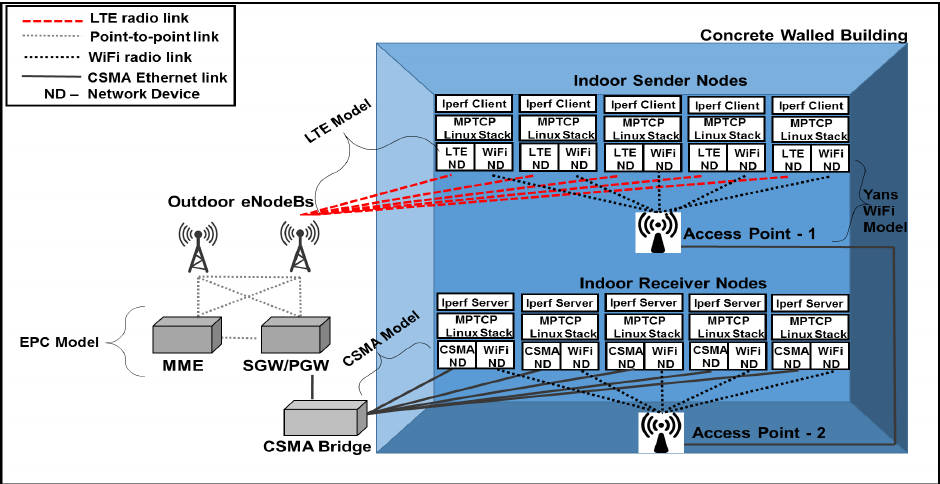
Figure 3. Simulation Setup